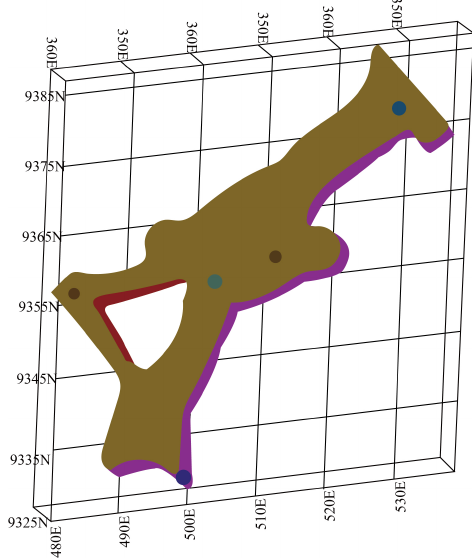
Figure 3: The seventh layered three-dimensional solid model of stope indicating Stope 1015